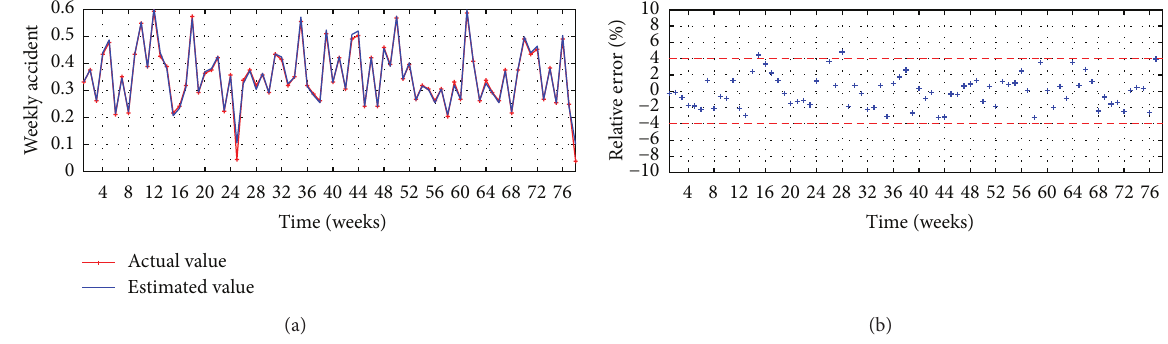
Figure 11: HSVD-ANN-PSO(9,11,1): (a) observed versus estimated and (b) relative rrror.